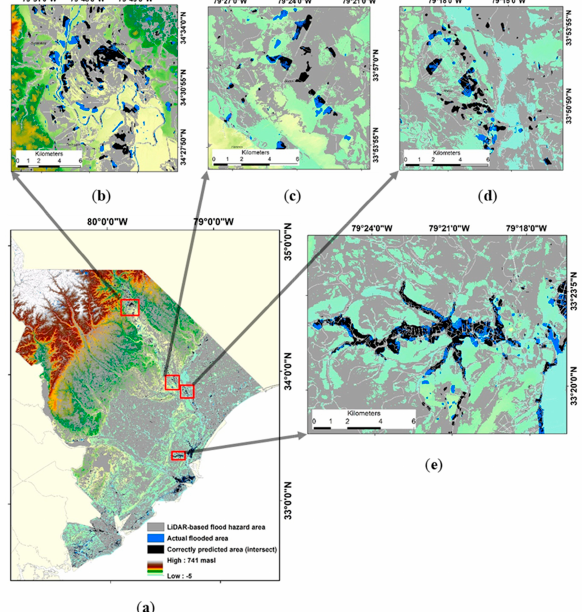
Figure 8. Raster output of flood hazard area analysis: ( a ) shows specific sites locally selected from severely affected areas across the state; ( b ) results from Chesterfield, Marlboro, and Darlington counties; ( c ) results from Marion county, ( d ) results from Marion and Horry county; and ( e ) results from Georgetown county.